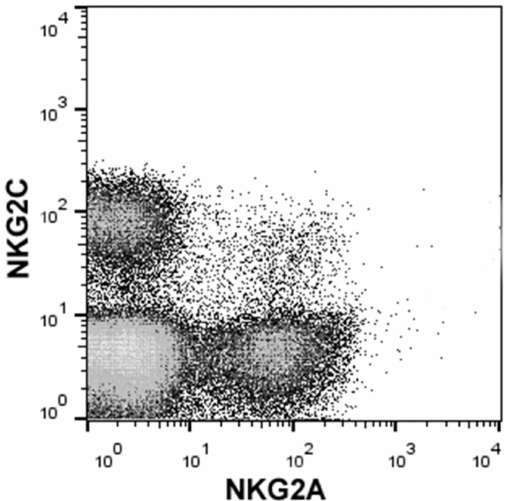
Figure 1. NK cells, freshly isolated from human peripheral blood by magnetic separation, stained with fluorescent-labeled antibodies to NKG2A and NKG2C with gating on CD3 – CD56 +